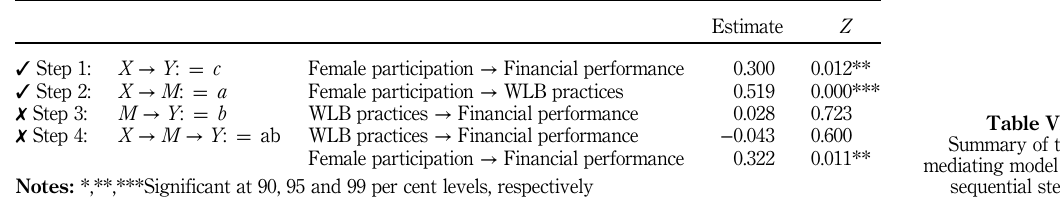
Table VII. Summary of